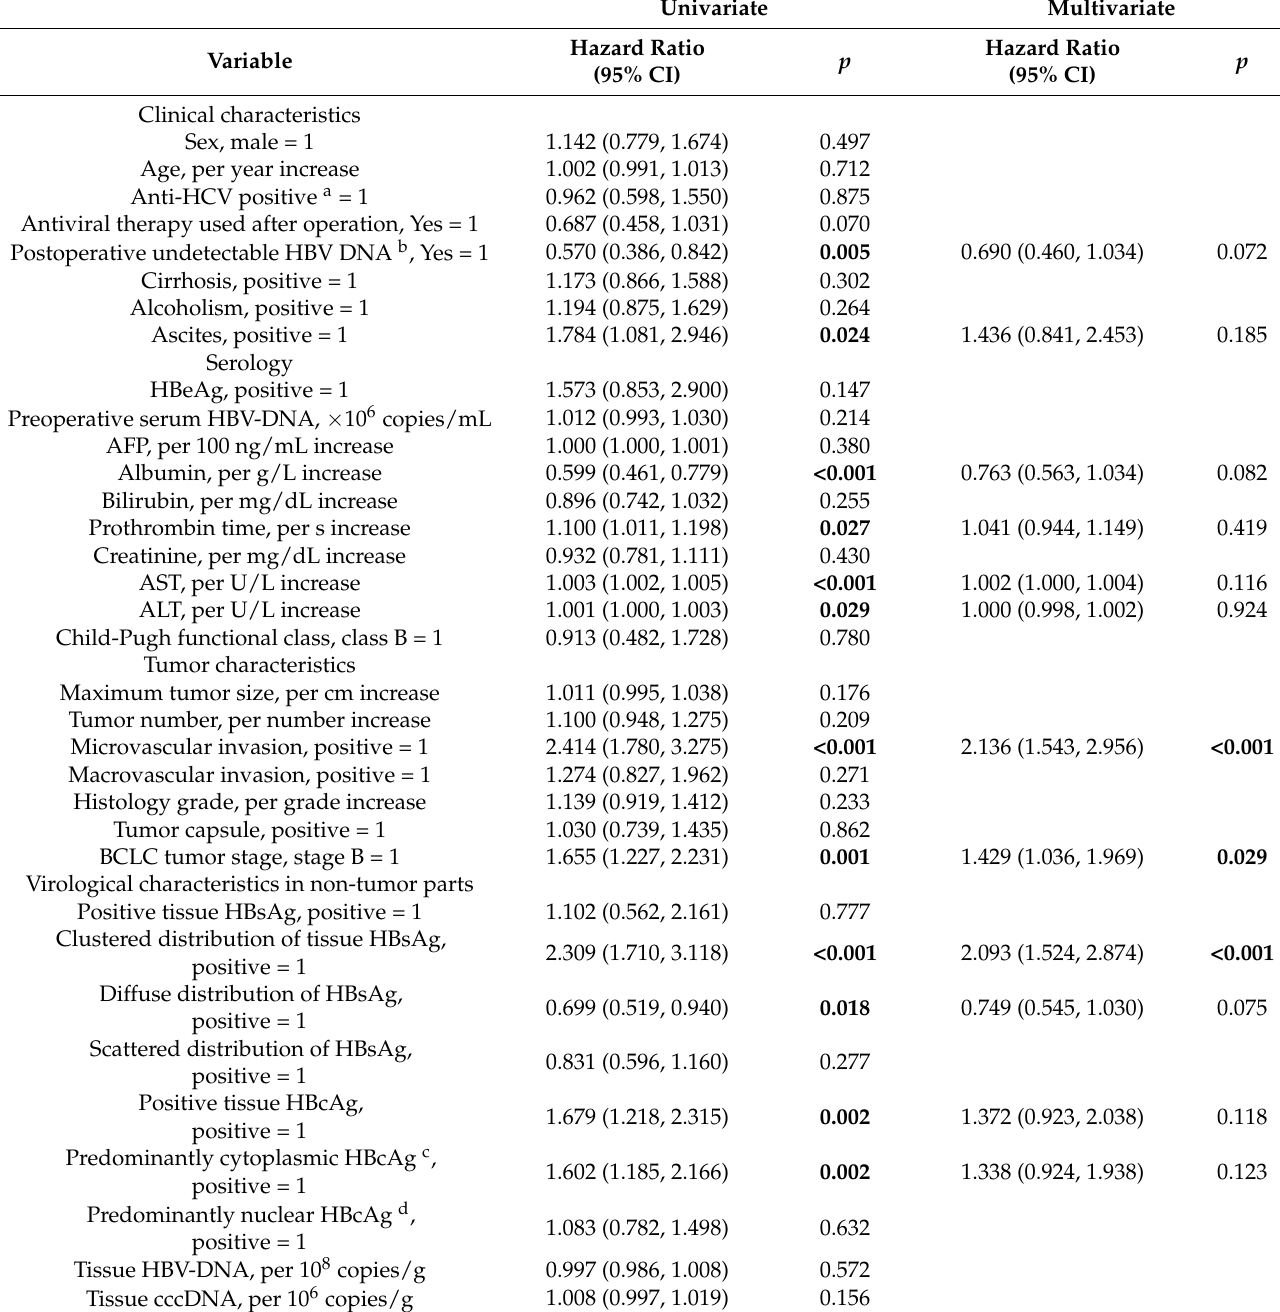
Table 4. Cox proportional hazard analysis for clinicopathological and virological parameters in relation to intrahepatic recurrence free